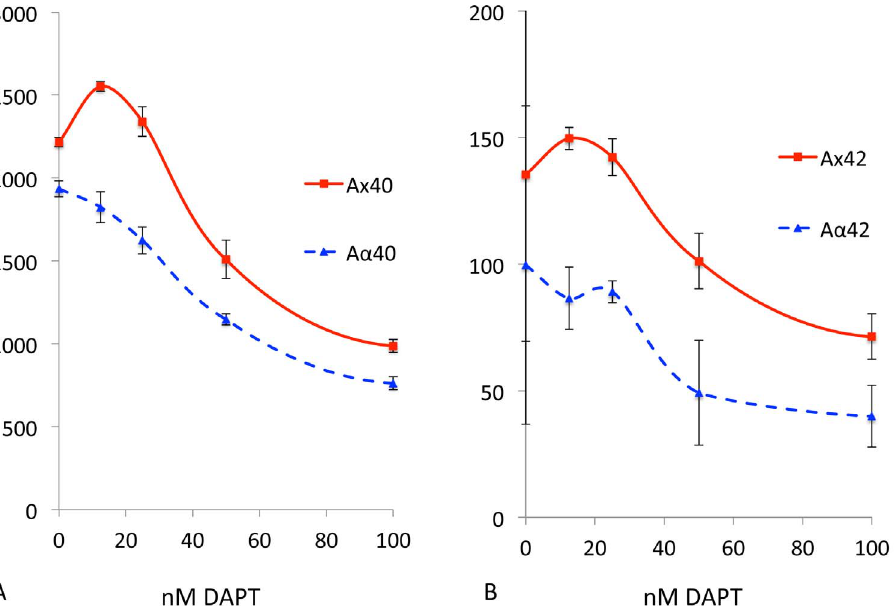
Figure 7. The secreted APP fragment generated by a and c secretase is not stimulated by DAPT. SH-SY5Y cells were treated with a combination of DAPT and media were analyzed using a combination of ELISA assays capturing secreted fragments ending at A b residue 40 and 42 and detecting with 4G8 to determine the total Ax40 and Ax42 (red circles, solid line) and the A b 40 and A b 42 values were subtracted to obtain A a 40 and A a 42 (blue triangles, dotted lines). Although similar trends were observed for Ax42 and Ax42 Tukey-Kramer analysis gave highly significant P values for increase in Ax40 ( , 0.05; A) but not for Ax42 ( . 0.7). ( , 0.0002; B). In contrast A a 40 showed a dose-dependent inhibition (p , 0.0001) for all doses except 12.5 nM (p=0.054) with no stimulation at 12.5 and 25 nM DAPT. A a 42 showed similar trends, but the values were not significant. Furthermore, elimination of an outlier control revealed a small, but significant increase in A a 42 (not shown).